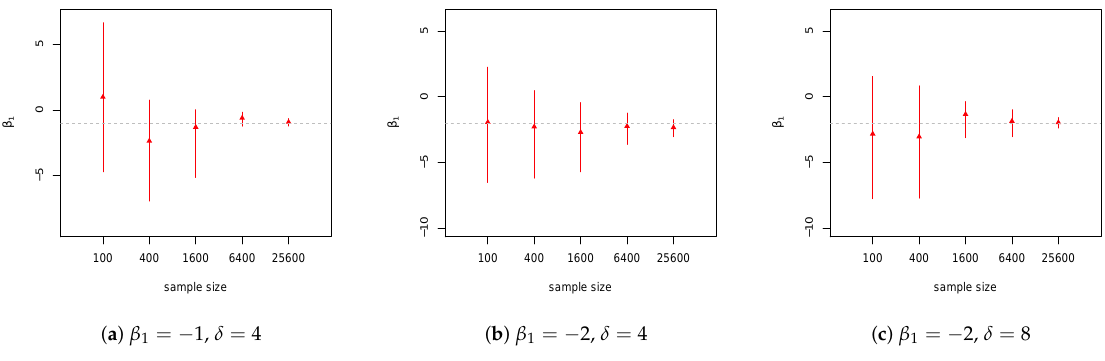
Figure 6. Credible intervals for the risk effect β 1 on the prevalence of misrepresentation for the Pareto loss severity